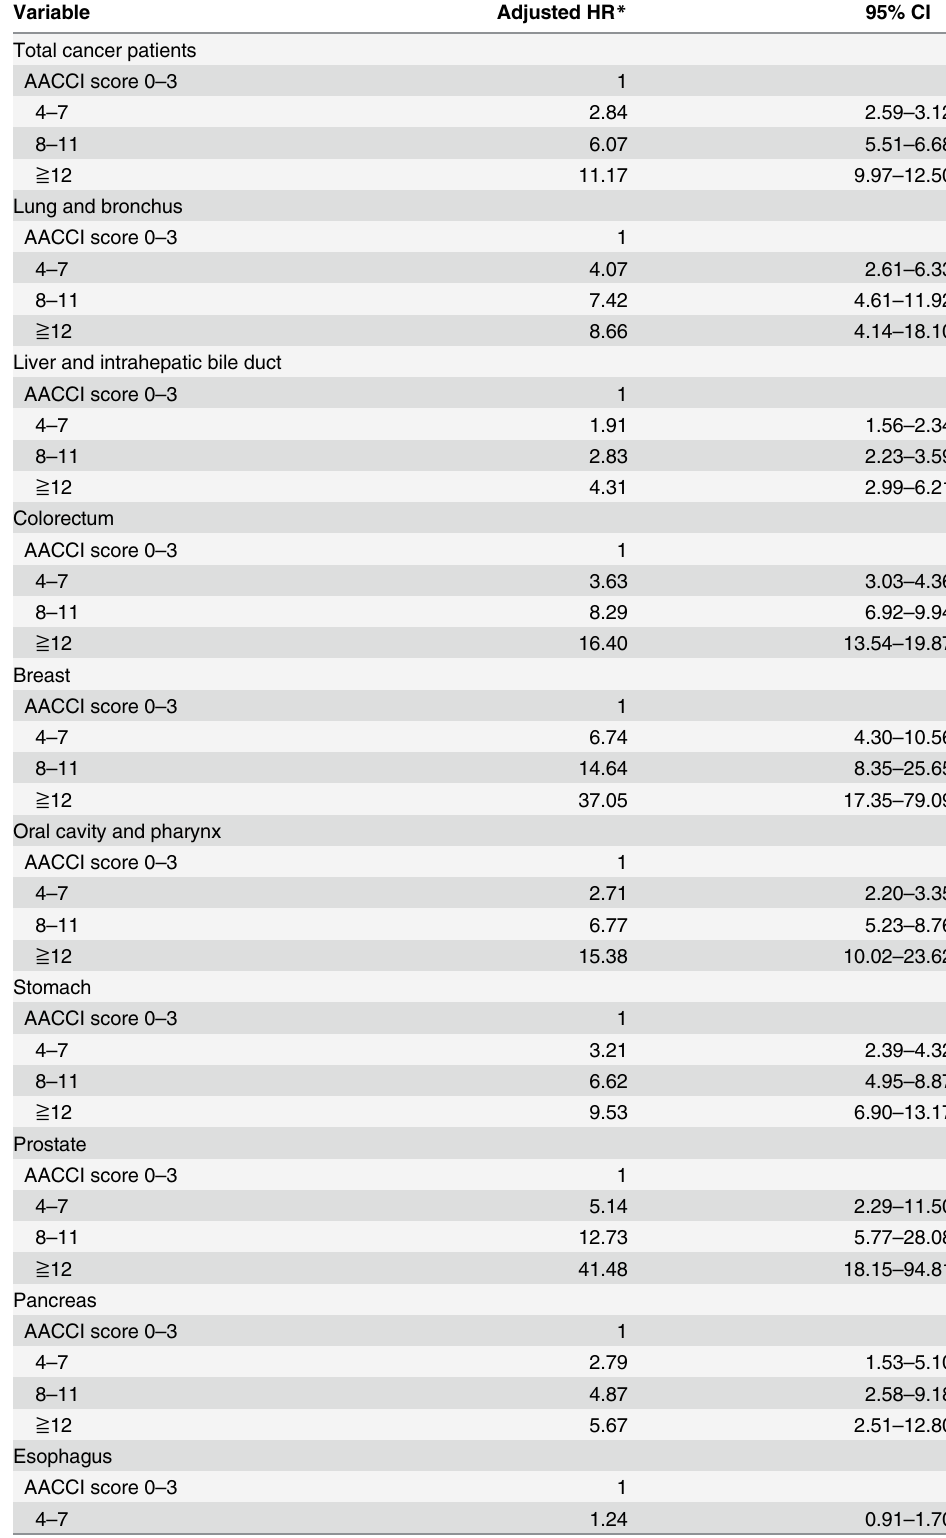
Table 7. Hazard ratios of individual adjusted age-adjusted Charlson comorbidity index score for